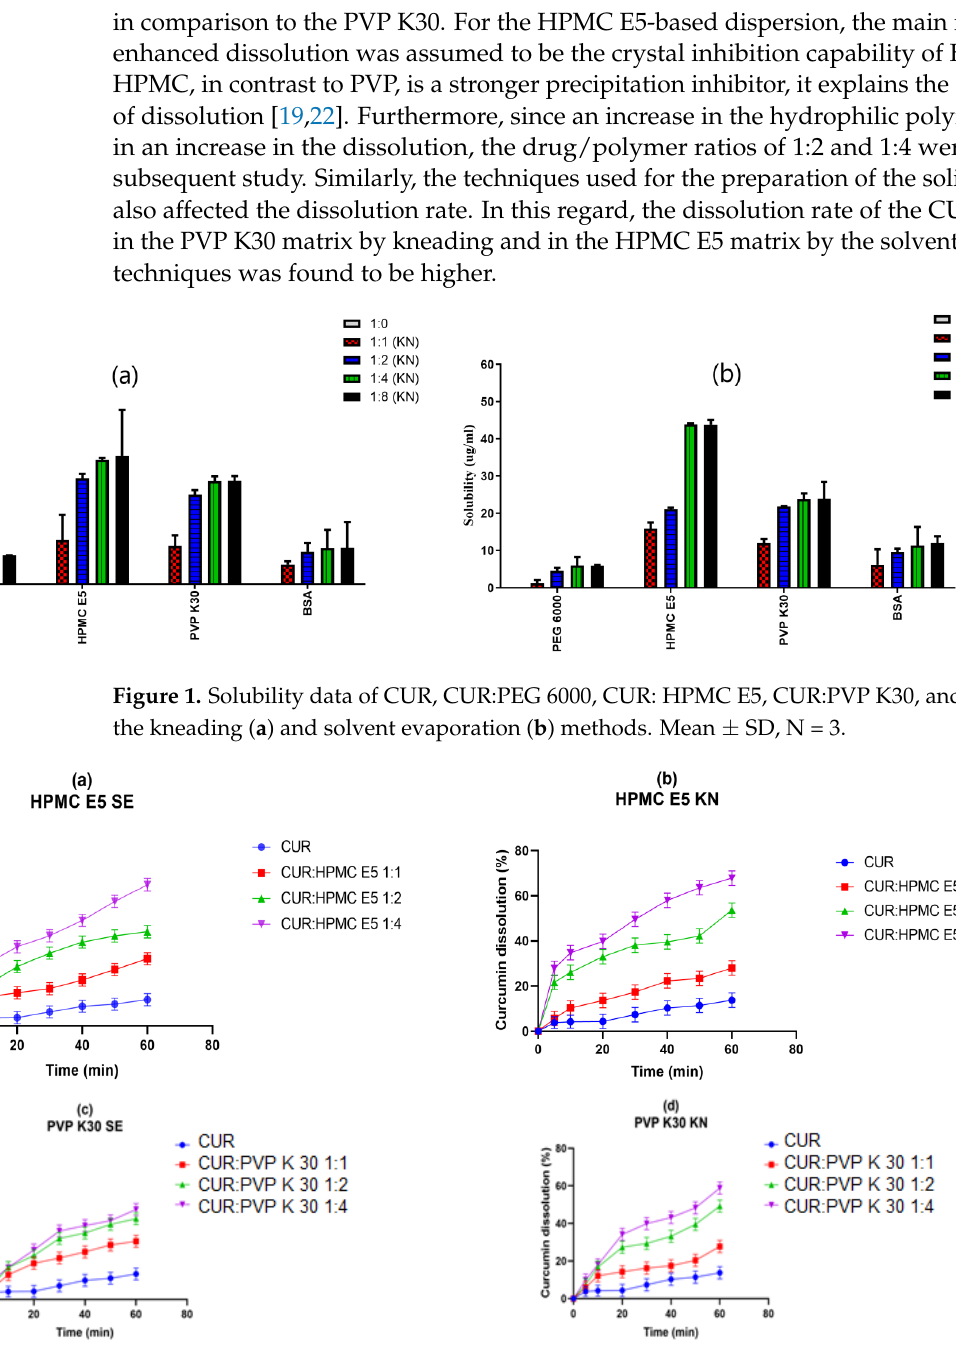
Figure 2. Mean dissolution profile of CUR and solid dispersions with ( a ) HPMC E5 SE, ( b ) HPMC E5 KN, ( c ) PVP K30 SE, and ( d ) PVP K30 KN. Mean ± SD, N = 3.